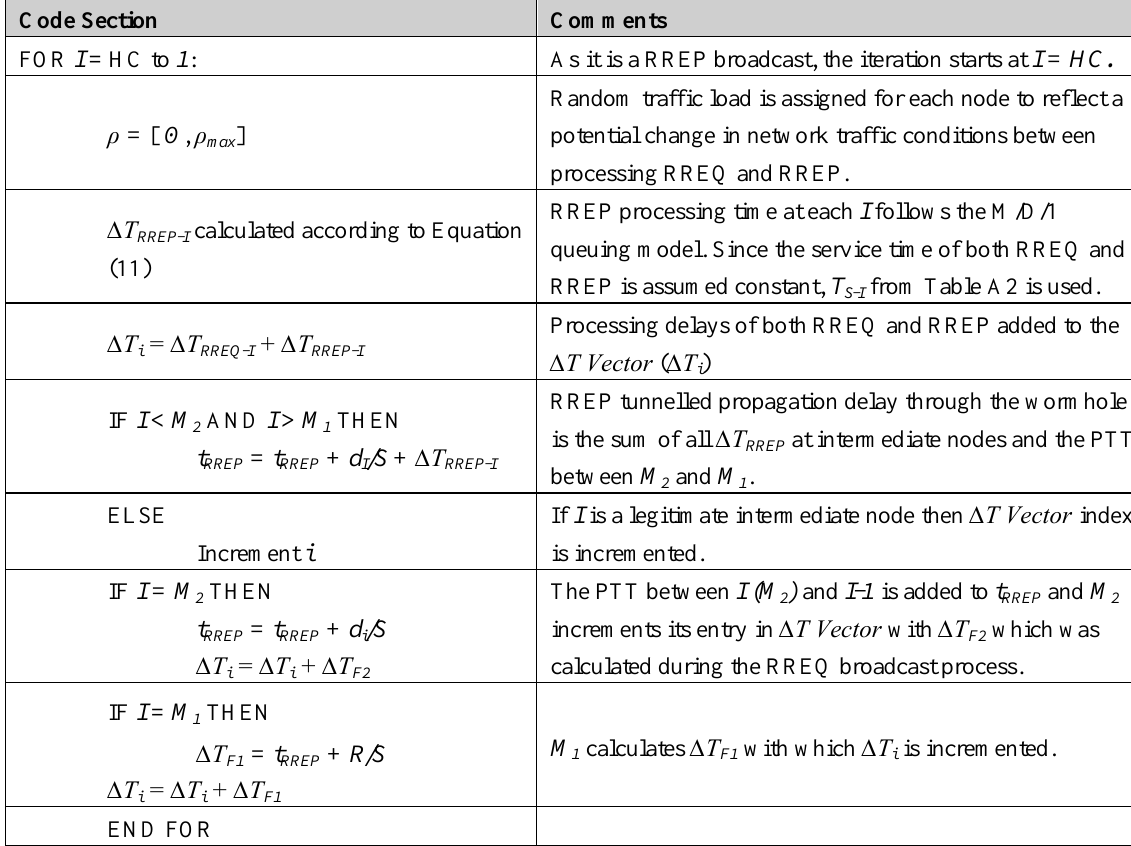
Table A3. Routing packet processing delay generation, time tampering and generation of the ∆T Vector during the RREP response